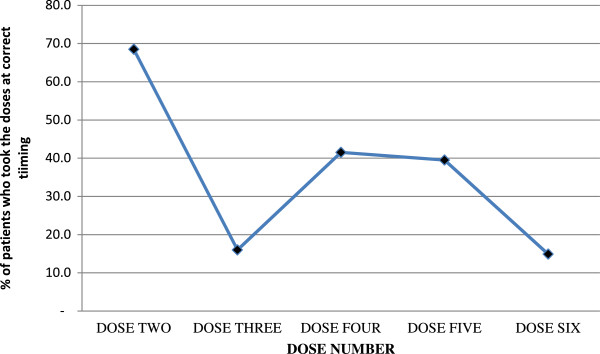
Correct timing pattern for ALu intake across the doses.